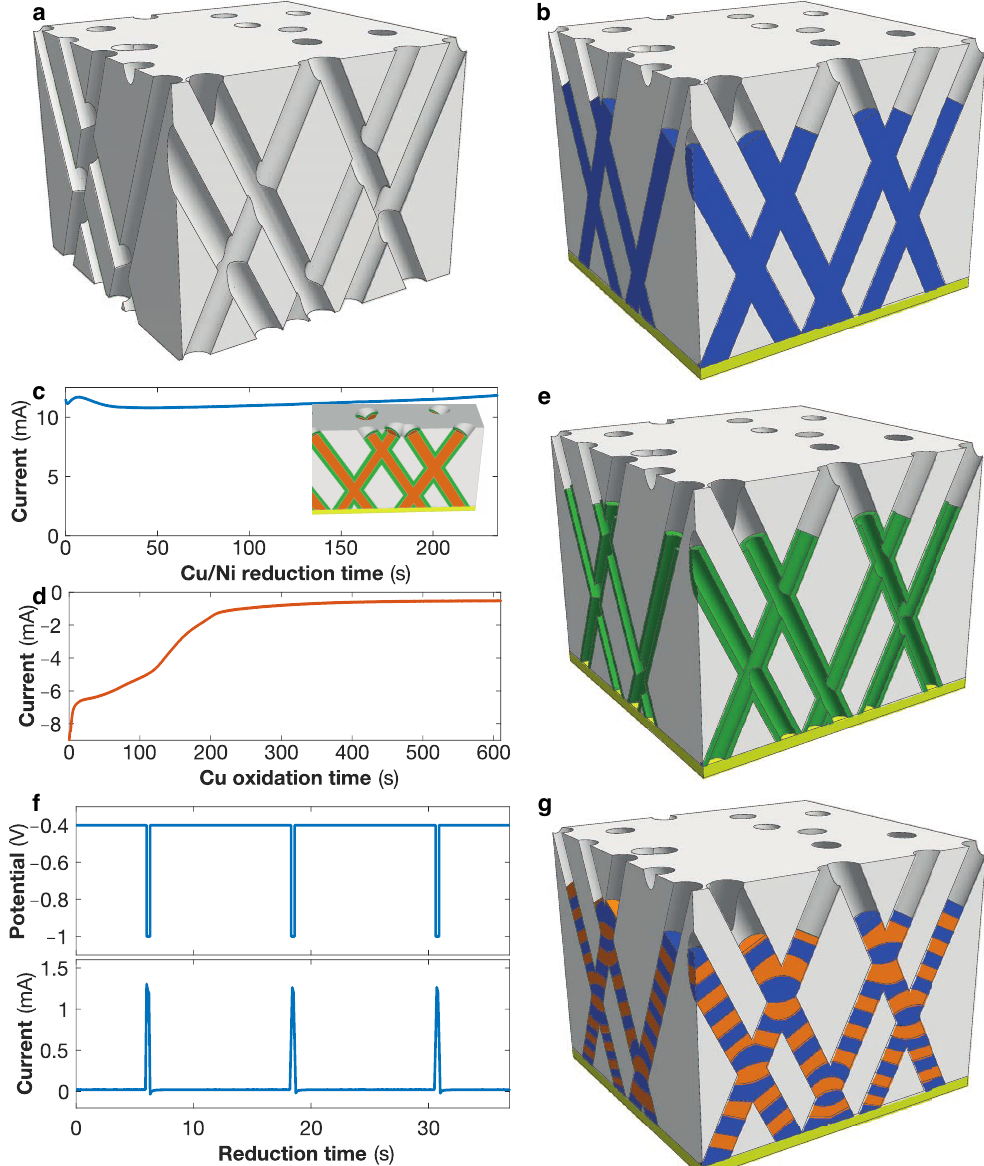
Figure 1. Schematics of ( a ) a polycarbonate template with 3D crossed nanopore network and ( b ) an interconnected nanowire network. ( c , d ) Fabrication of interconnected Ni nanotube networks. ( c ) Growth of interconnected Cu/Ni core/shell nanocable networks at constant potential of − 1 V and ( d ) dealloying process to selectively etch the Cu core at constant potential +0.2 V. The inset in panel ( c ) shows a schematic of a crossed Cu/Ni core/shell nanocable network. ( e ) Schematic of a crossed Ni nanotube network. ( f ) Fabrication of interconnected multilayered nanowire networks using a pulse electrodeposition technique to successively deposited the ferromagnetic and non-magnetic metal layers. ( g ) Schematic of a crossed nanowire network with a succession of ferromagnetic and non-magnetic